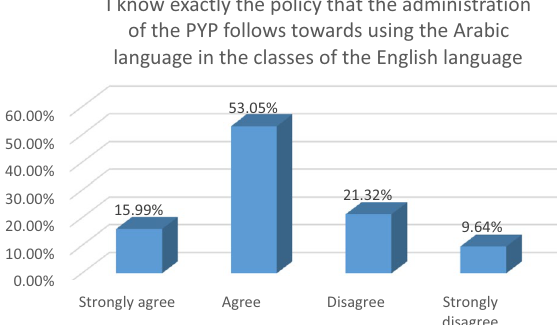
Fig. 3 Students’ Knowledge about the LEP of the PYP towards